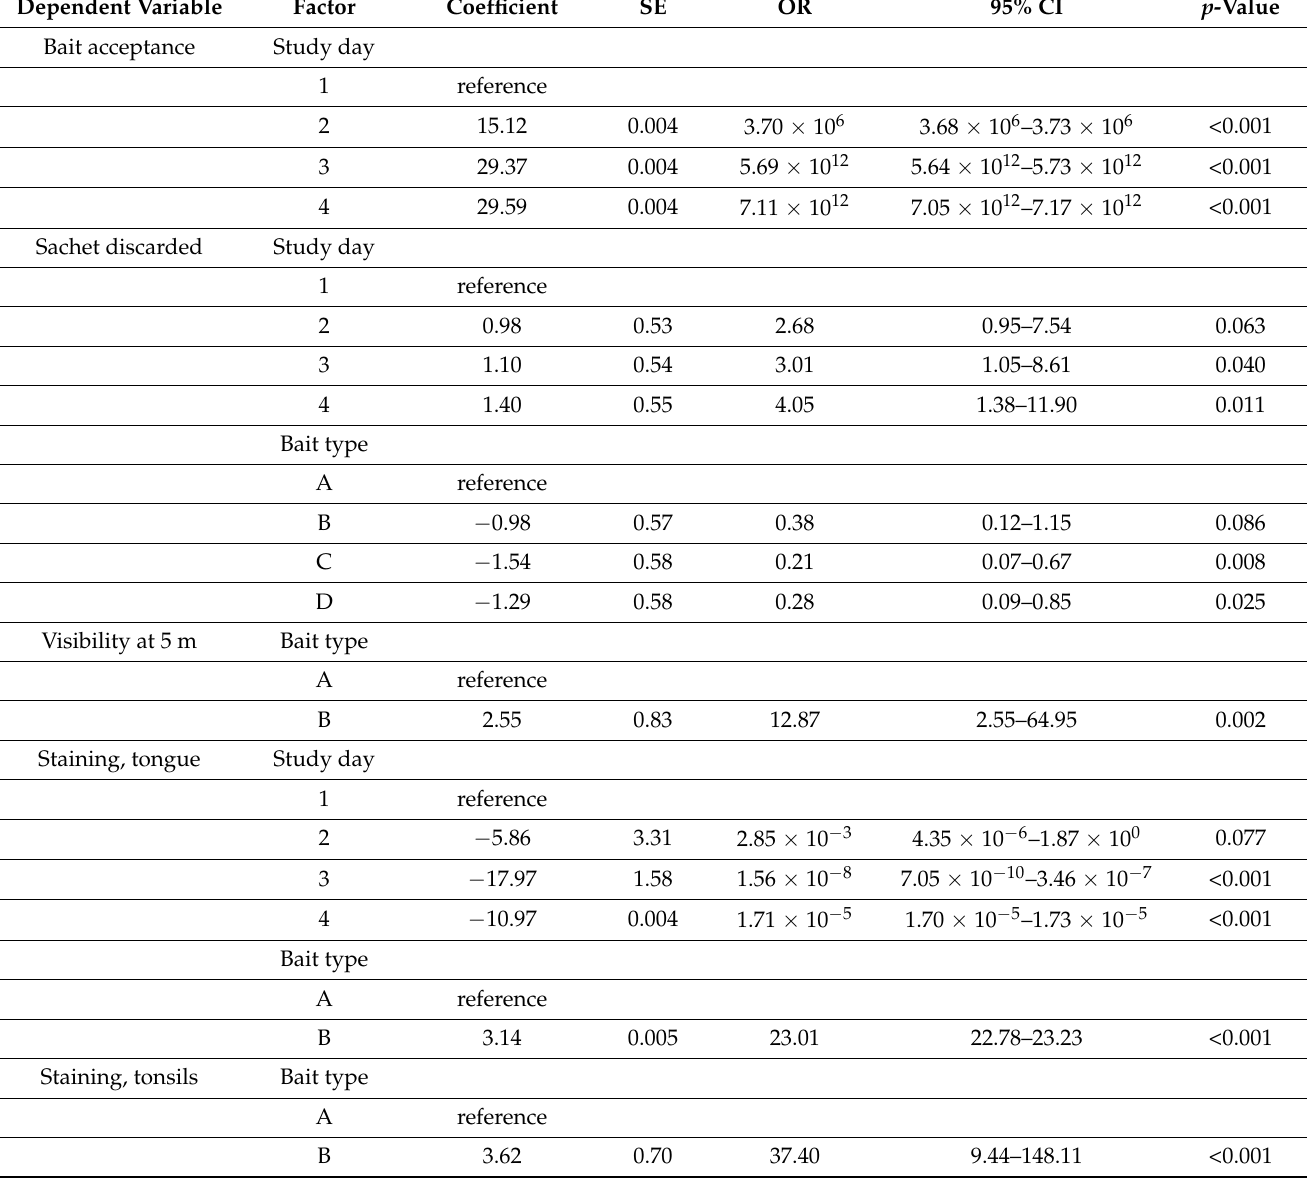
Table 8. The final generalized linear mixed-effects model indicating factors associated with bait acceptance, sachet discarded, visibility at 5 m, staining of the tongue, and staining of the oral mucous membranes in